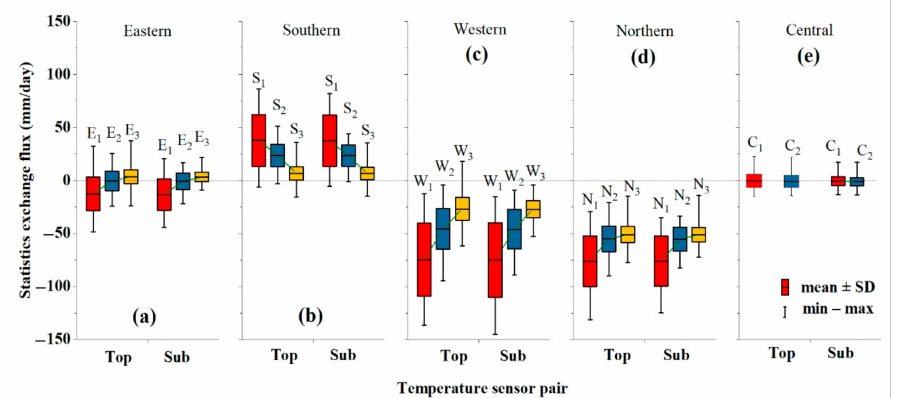
Figure 8. Statistical hyporheic fluxes at 14 sampling sites during 2016 using the VFLUX 2 model based on top (depths of 0 and 5 cm) and sub (depths of 5 and 10 cm) sensor pairs. Positive flux values represent downward flow and negative values represent upward flow. Site locations see Figure